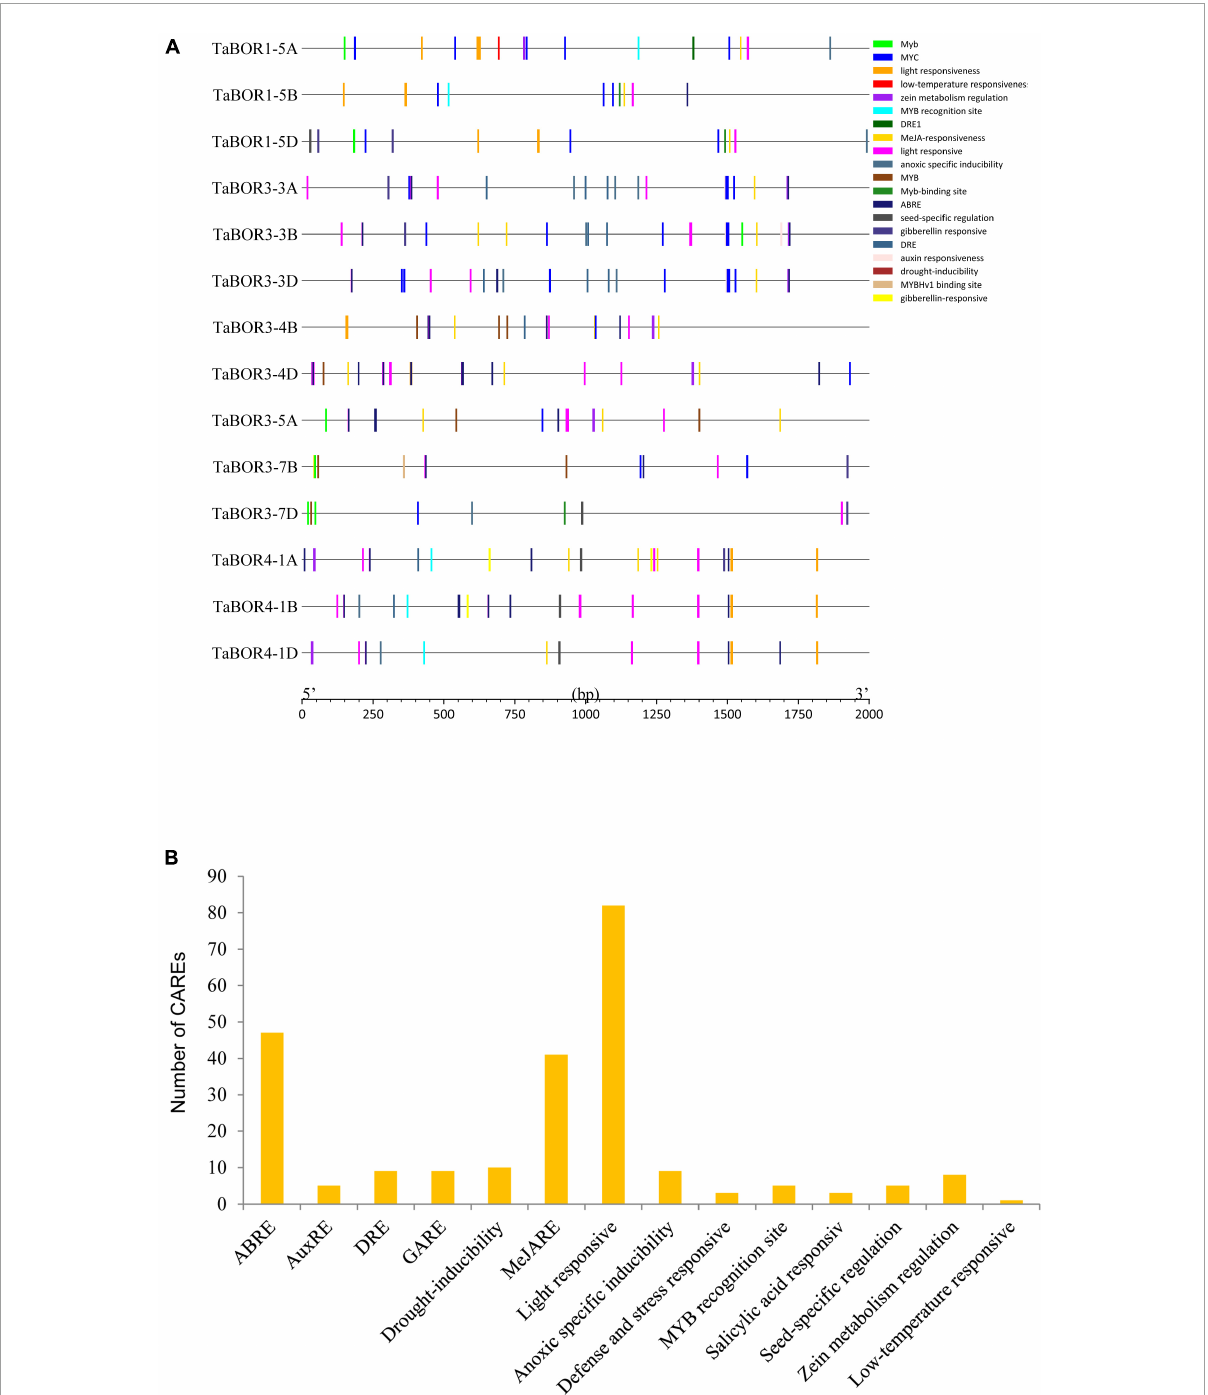
FIGURE5 Cis-element identification in TaBOR promoters. (A) Elements are indicated by different colors. (B) Most commonly occurring CAREs in TaBOR s.